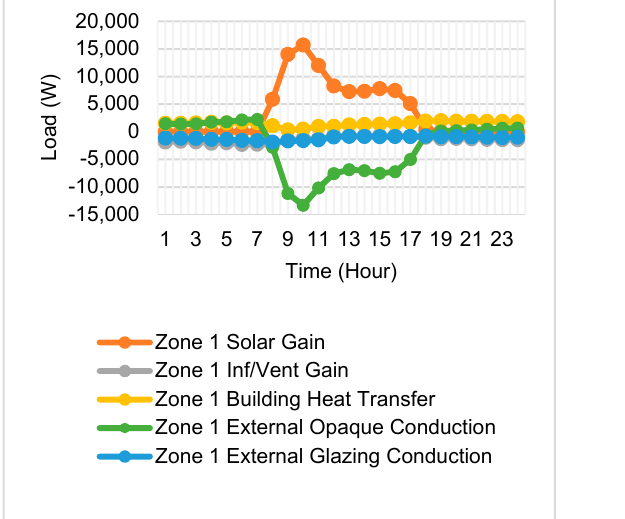
Figure 10. External dry bulb temperature and internal dry bulb temperatures in Hudhayfah Mosque by the hour during day 20 (Winter).